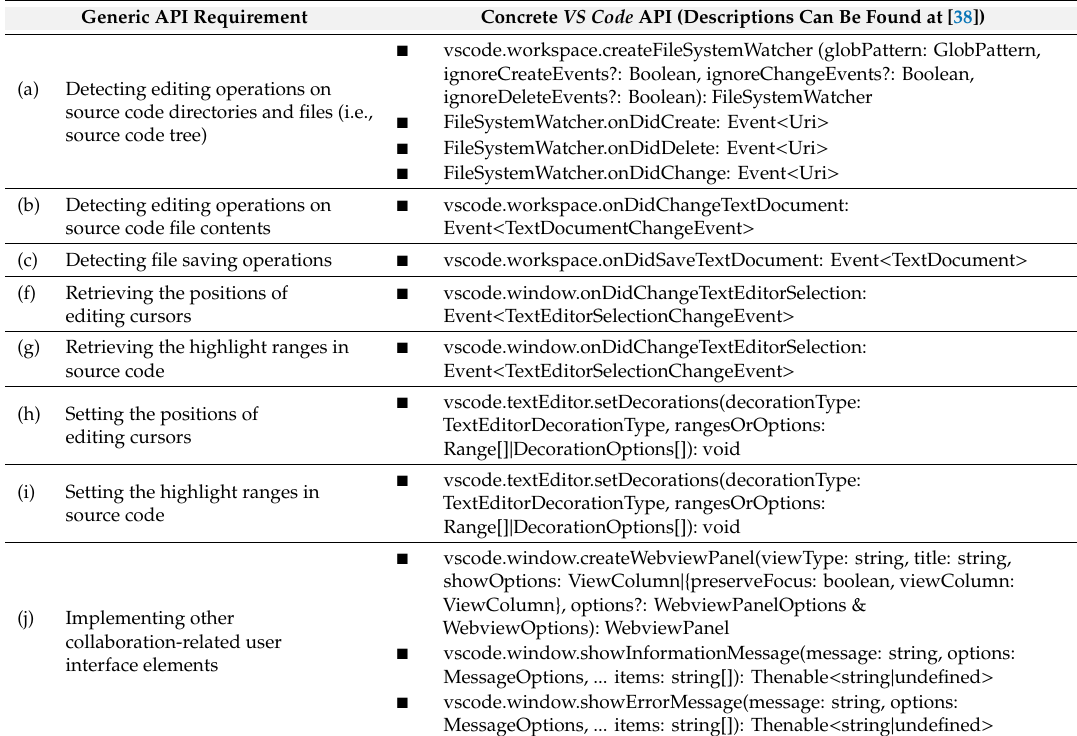
Table 1. Major APIs required for implementing real-time collaboration functionalities. Generic API